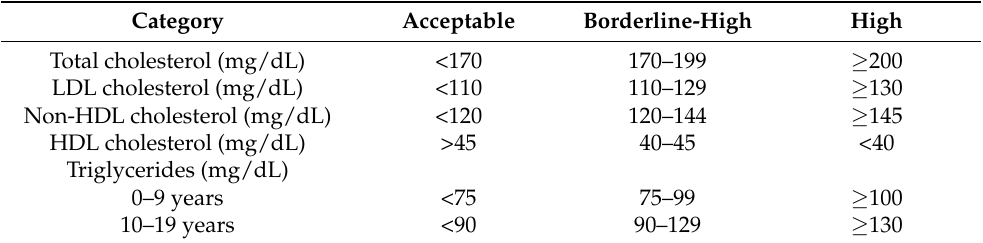
Table 1. Reference values of lipidic pattern in children and adolescents. LDL = low-density lipopro- tein; HDL = high-density